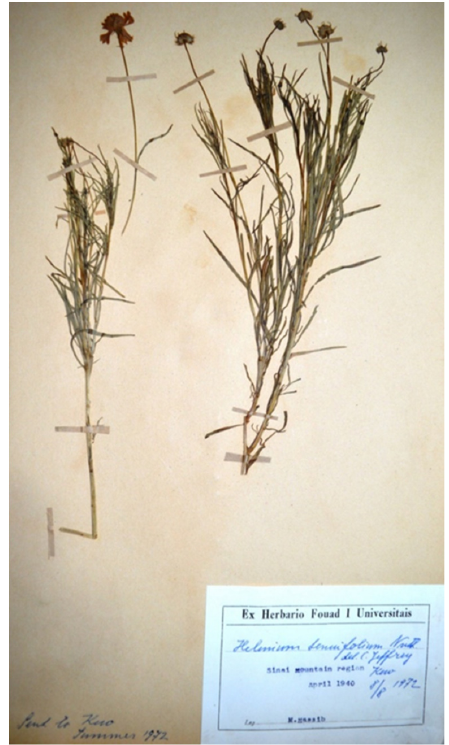
Figure 1. Image of the herbarium specimen of Helenium amarum var. amarum